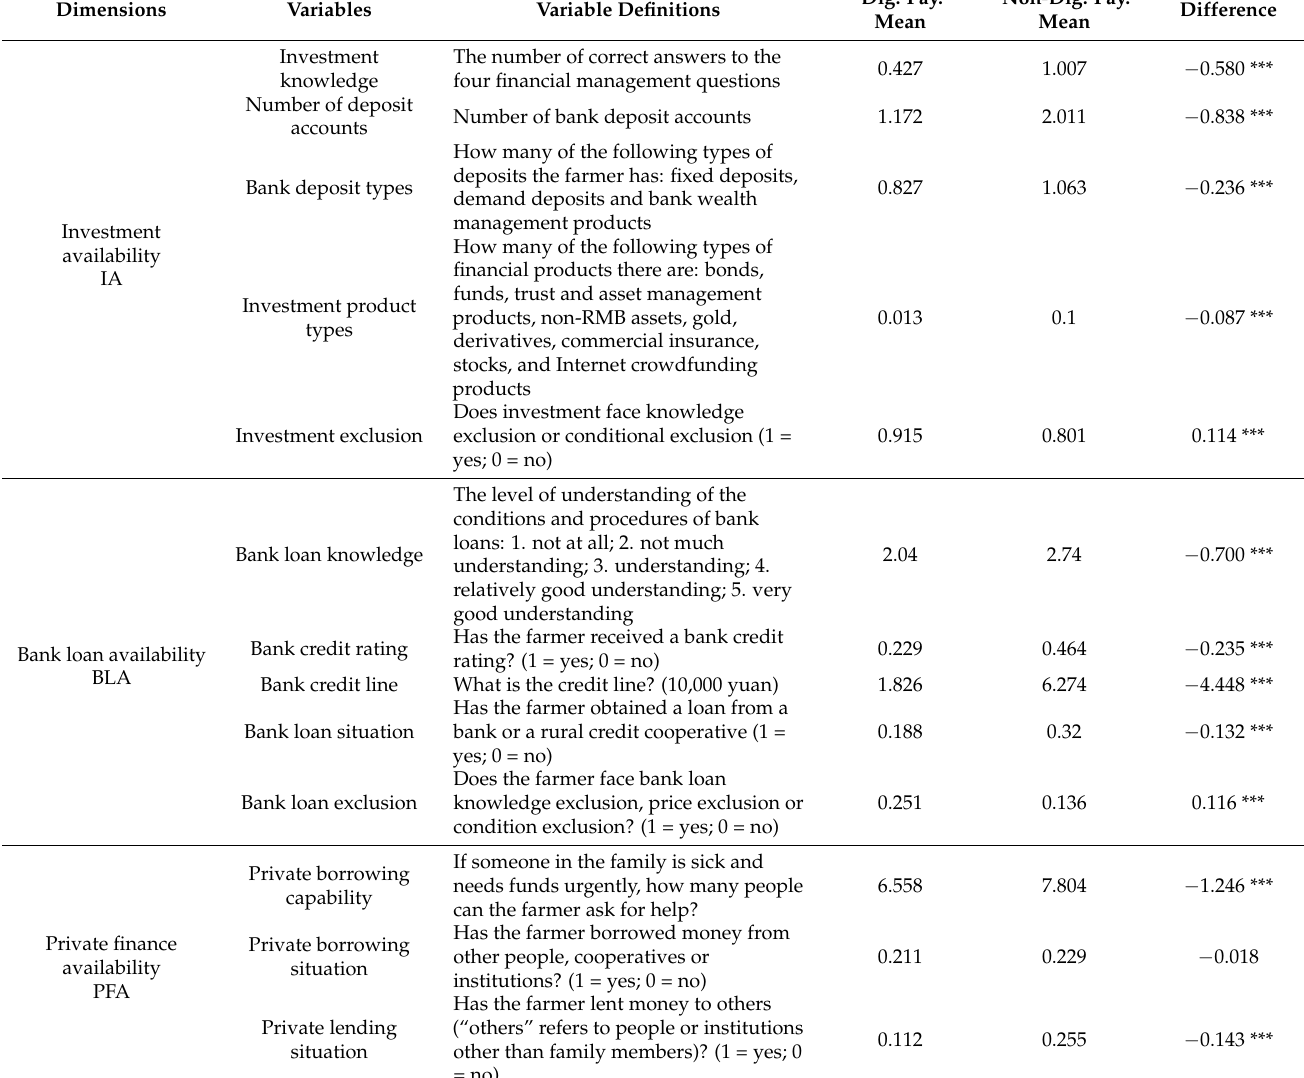
Table 5. Index of rural households’ financial